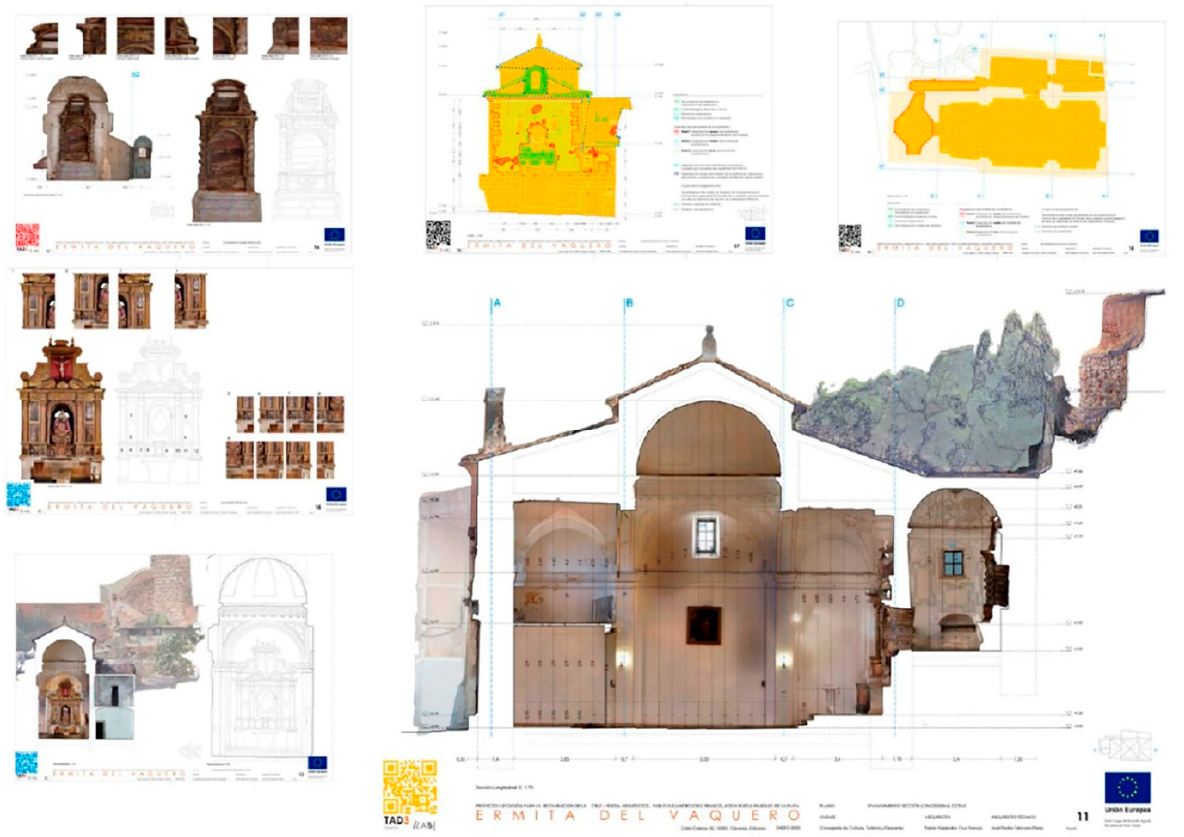
Figure 6. Planimetry of the execution project for the restoration of the Vaquero’s Hermitage of C á ceres. Author Pablo Alejandro Cruz